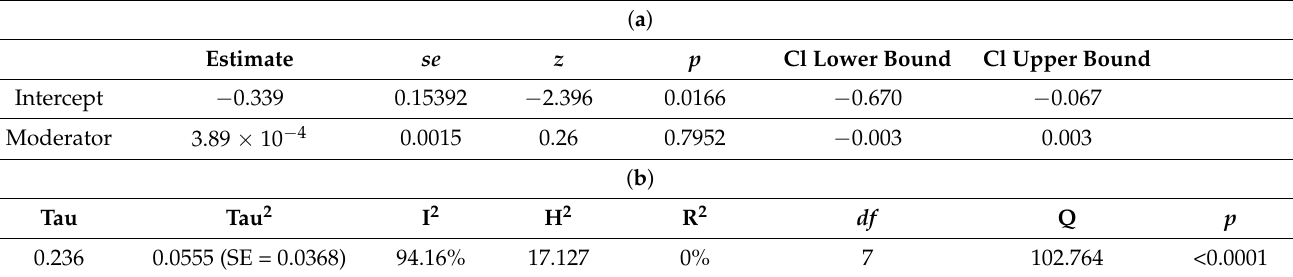
Table 3. ( a , b ) Mixed effect of the study review.